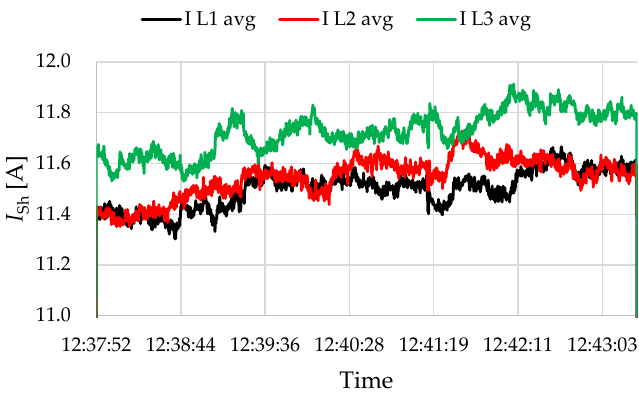
Figure 17. Sheaths currents measured in Substation 2. Sheaths cross-bonded according to: L1 → L3, L2 → L1, L3 → L2 (Sh4). Operation only with the analyzed line.